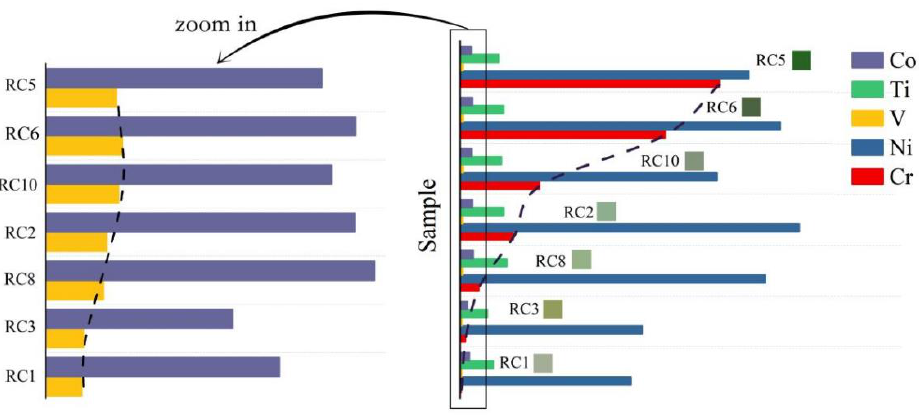
Figure 12. ( a ) The relationship between the green shade of the sample and the contents of related trace elements. ( b ) Zoomed-in version of Figure 12a.